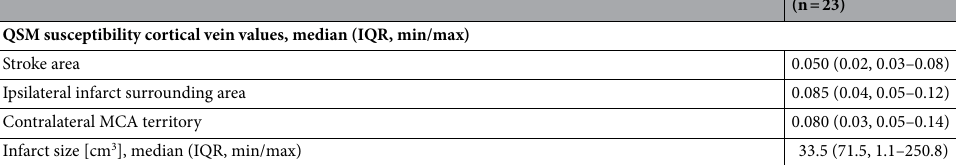
Stroke patients (n = 23)